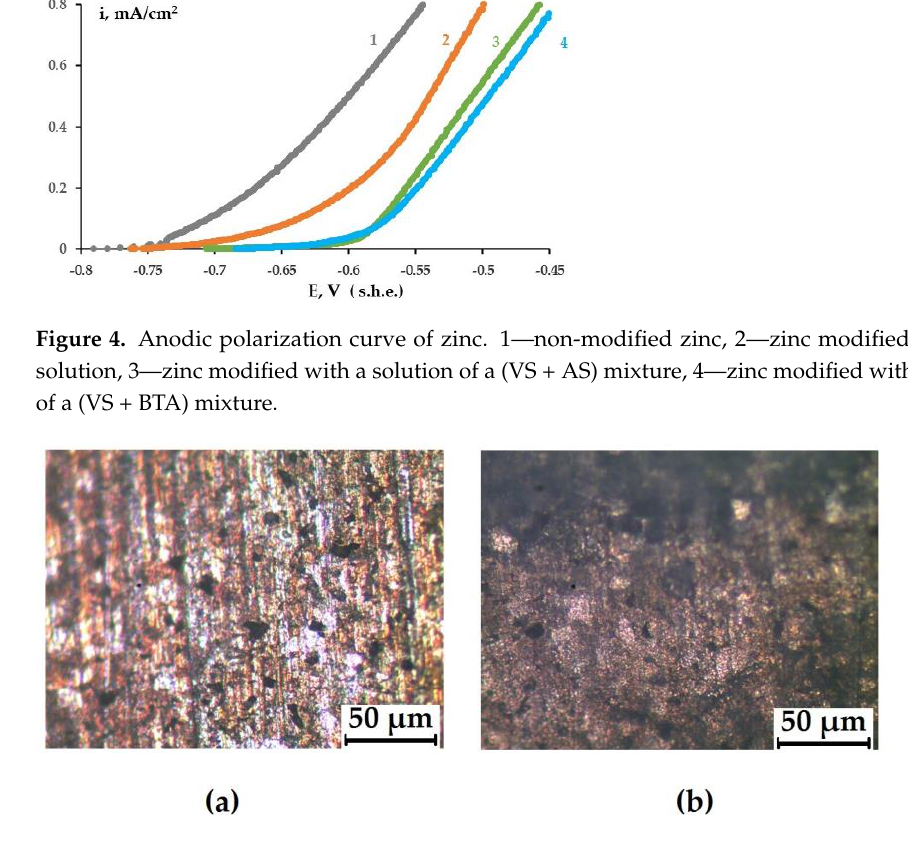
Figure 5. Zinc surface after taking the anodic polarization curve, ( a ) non-modified zinc; ( b ) zinc modified with a VS solution.